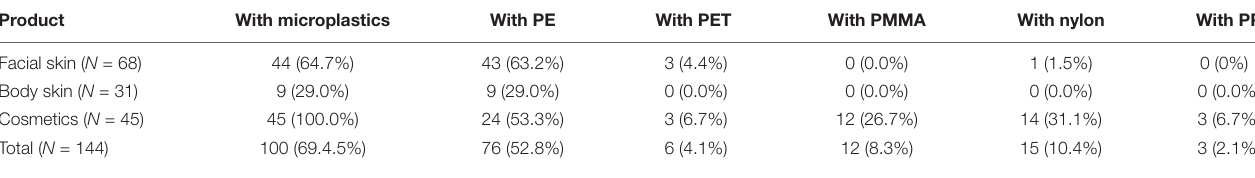
TABLE 1 | Number of personal care and cosmetic products containing microplastics for sale in Macao retail stores (PE, polyethylene; PET, polyethylene terephthalate, PMMA, polymethyl methylacrylate; PP, polypropylene).